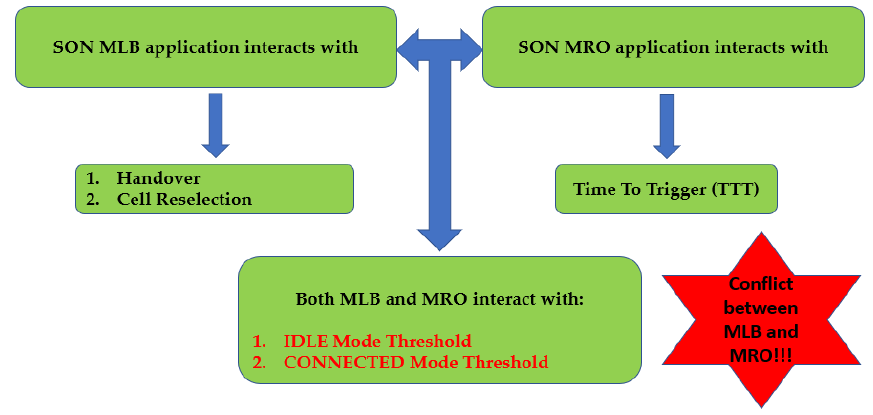
Figure 8. Conflicts between MLB and MRO.